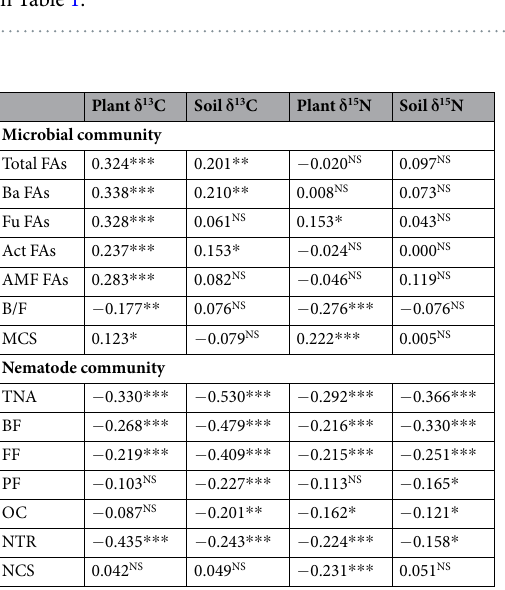
Figure 5. Percentages of variation in soil microbial and nematode properties explained by ecosystem isotopic values ( δ 13 C and δ 15 N) at the regional scale in grasslands on the Mongolian Plateau. Abbreviations are explained in Table 1.